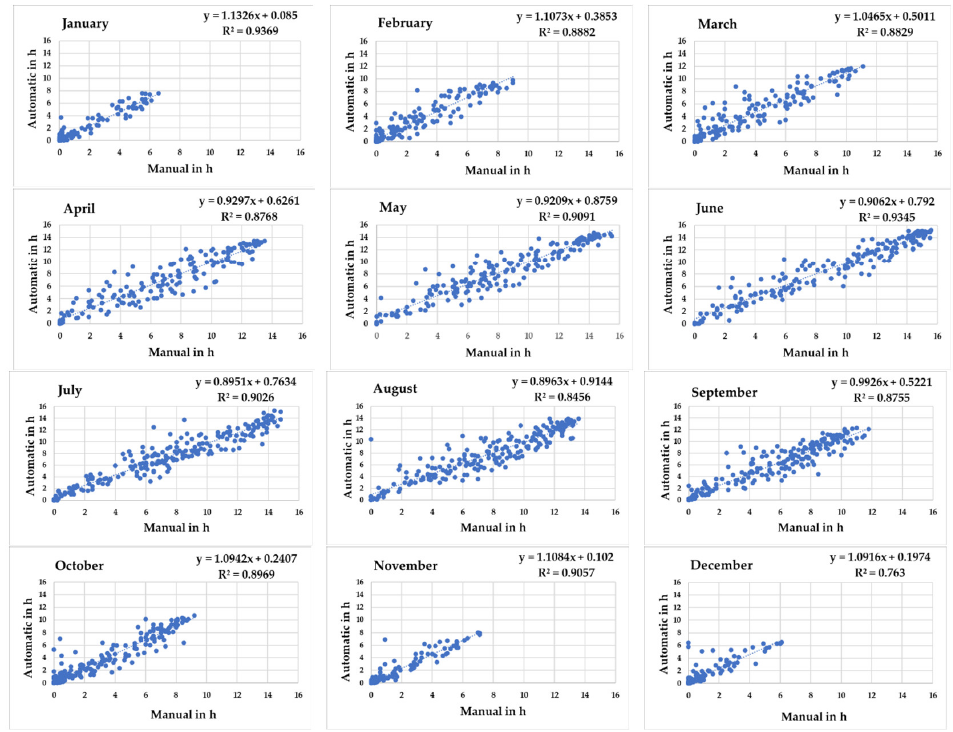
Figure 6. Scatterplots of relationship between manual and reconstructed measurements of daily